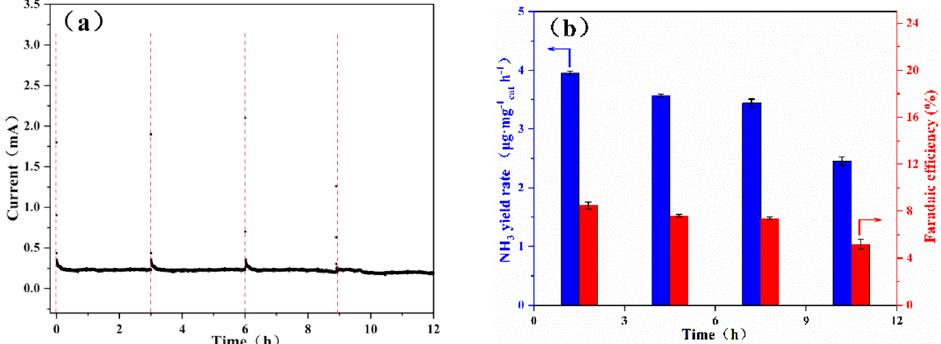
Figure 14. ( a ) Variation of electric current in the four successive operations each lasting 3 h. ( b ) Ammonia synthesis rates and Faradaic efficiency of each electrolysis cycle.